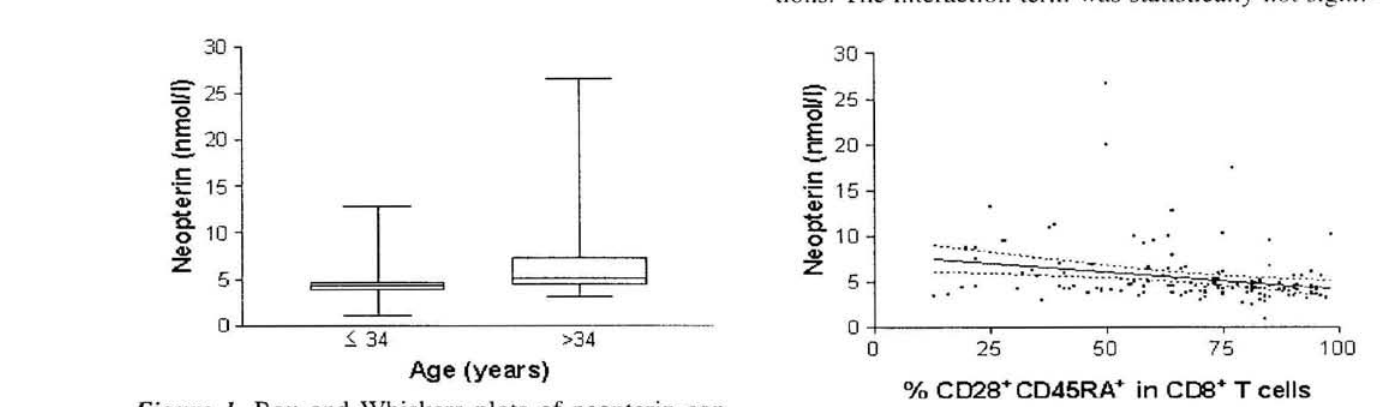
Figitre 1. Box and Whiskers plots of neopterin con- centrations of individuals with different age. The box extends from the 25'" percentile to the 75"' percentile, with a horizontal line at the median (50"' percentile), bars showing the ränge of the data. The median neopterin concentration of the group with age above 34 years is statistically significant higher (p<0.0001) compared to to the group with age equal or below 34 years.